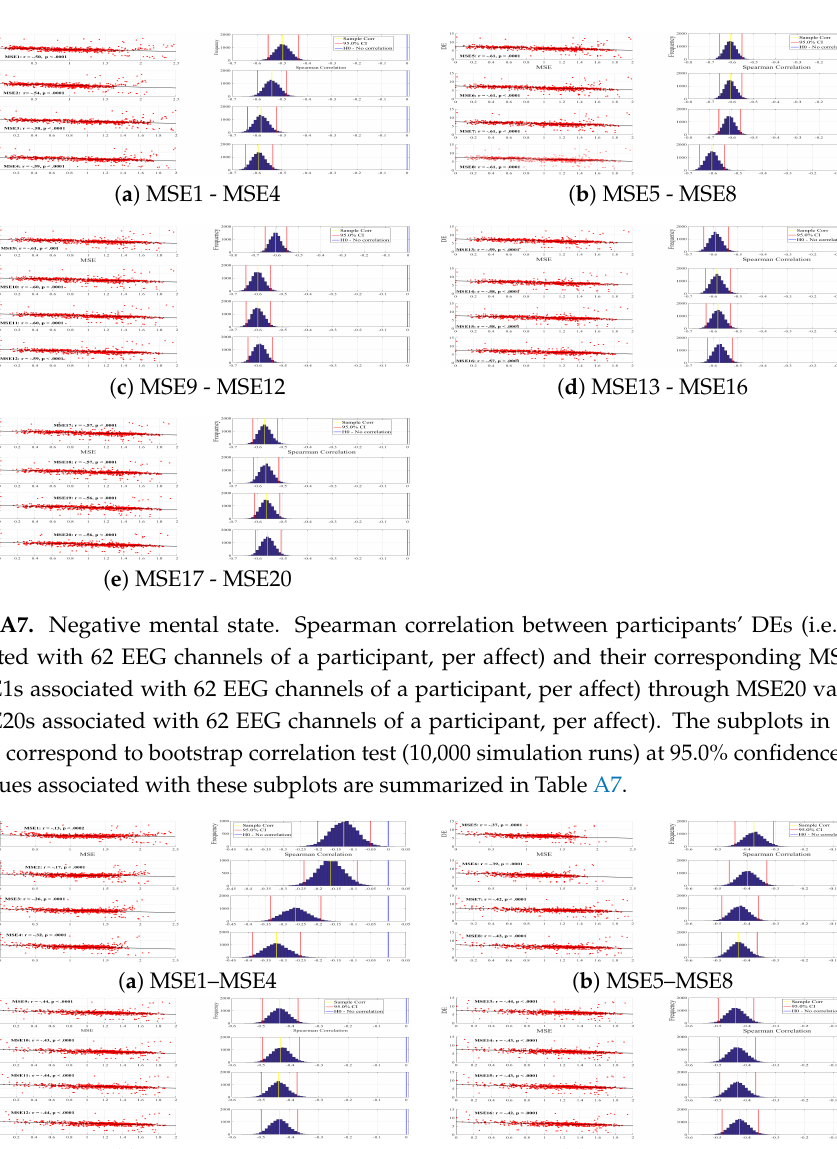
the column “p” of their corresponding tables.